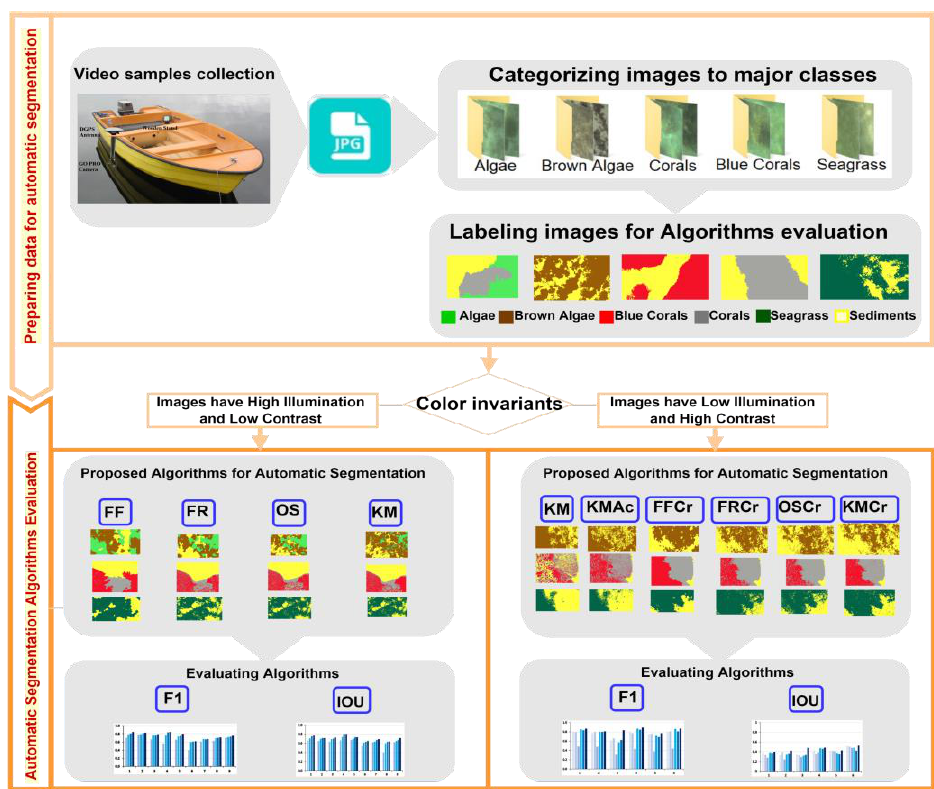
Figure 2. Methodology workflow of this study. KM: KM with RGB image; KMAc: KM with Ac channel; FF: FF with Cr channel; FR: FR with Cr channel; OS: OS with Cr channel; KM: KM with Cr channel.